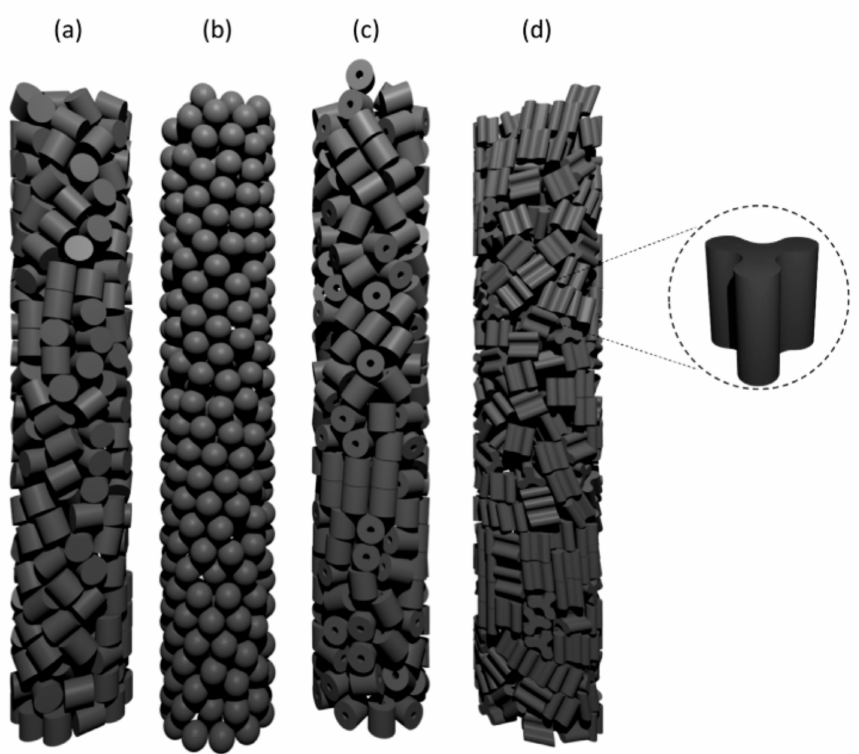
Figure 11. Four fixed bed models/packings investigated by CFD (tube wall invisible). Tube length: 0.1 m; diameter: 0.021 m; tube to particle diameter ratio: 4.7. ( a ) Cylinders, ( b ) spheres, ( c ) rings, and ( d ) trilobes. © 2019 American Institute of Chemical Engineers